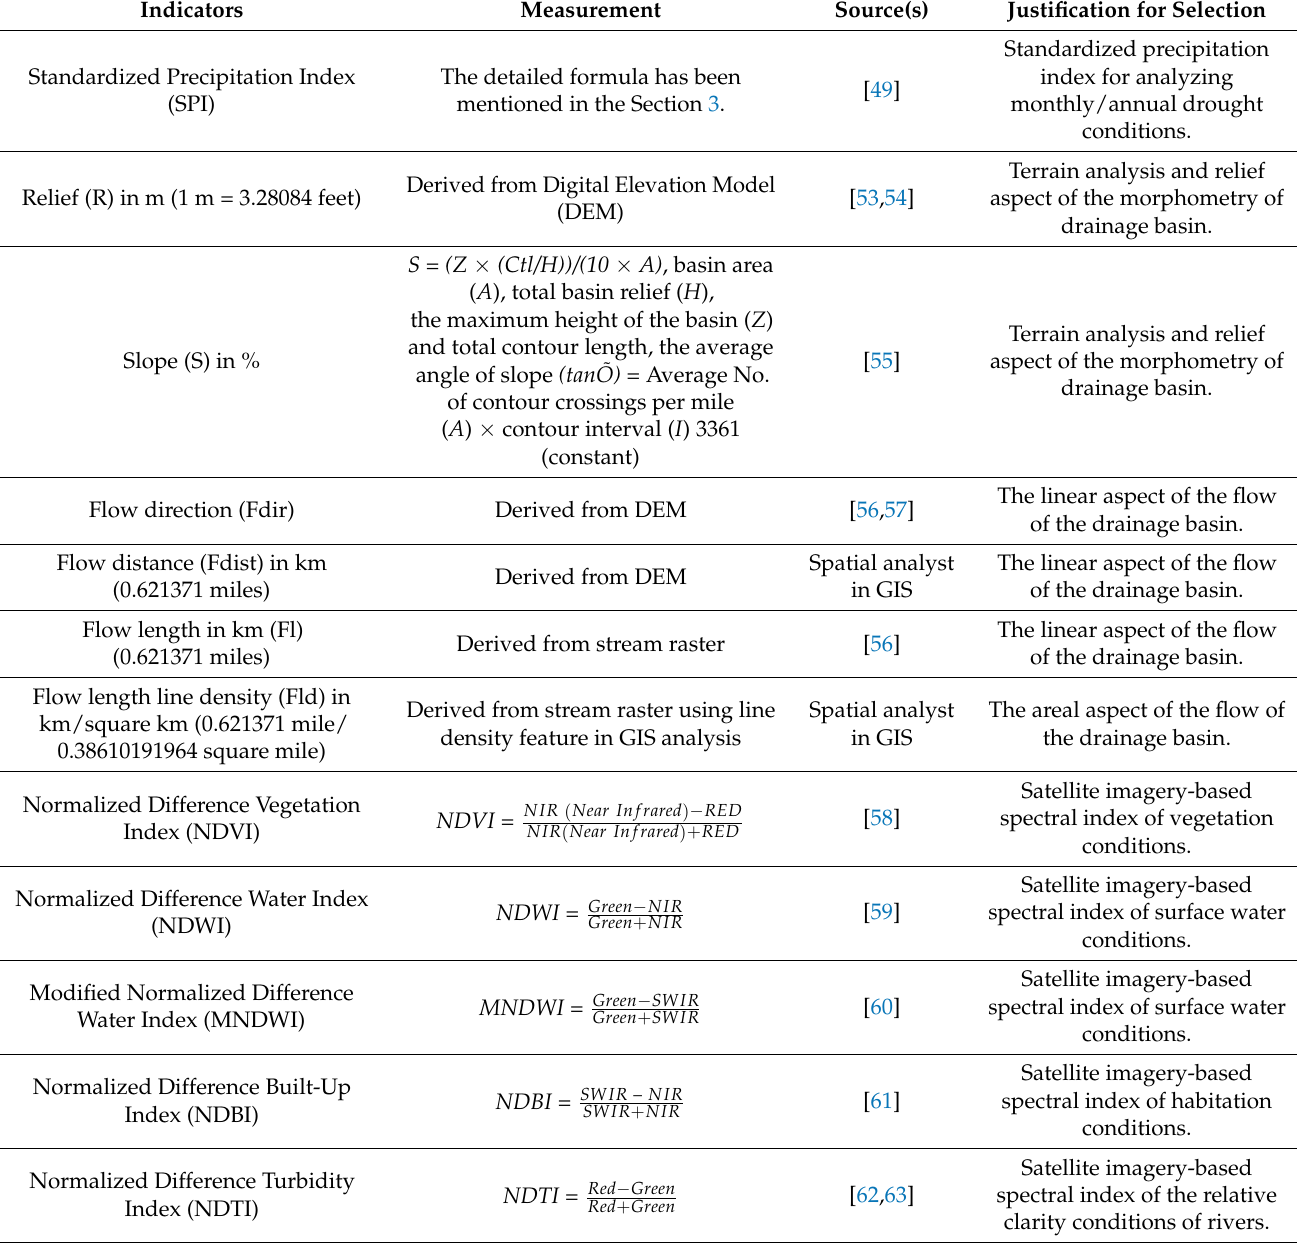
Table 3. Details of the parameters and indicators used in the present